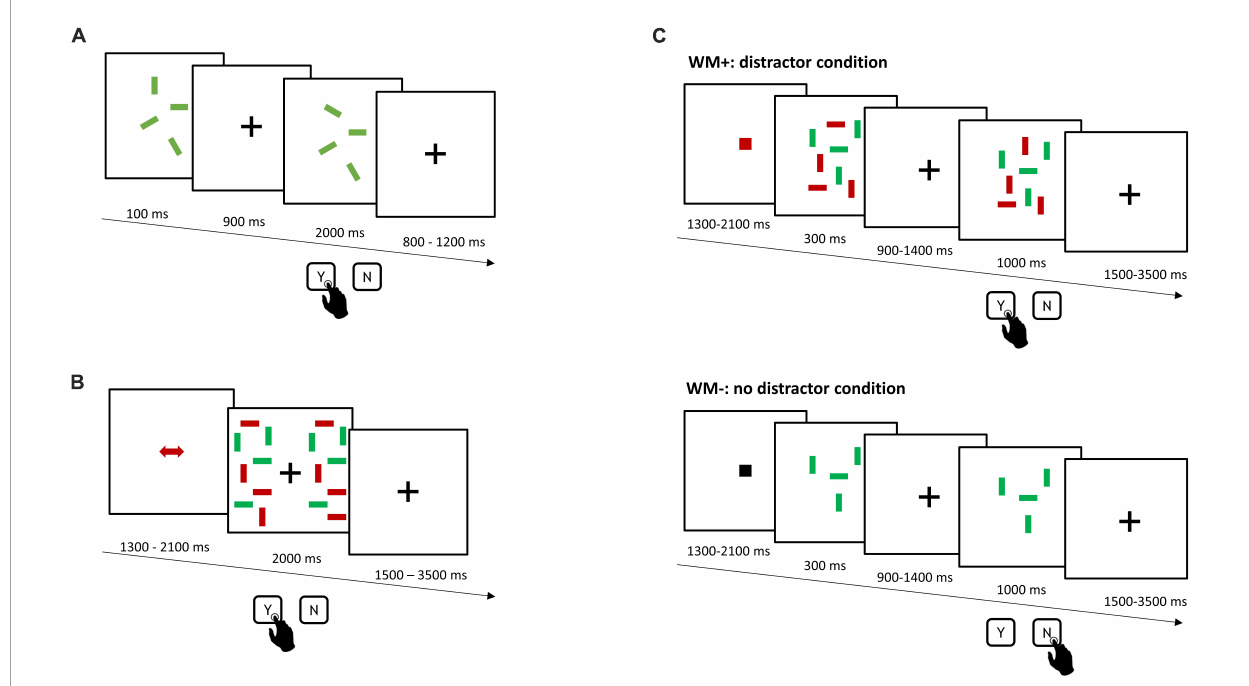
FIGURE1 Schematic overview of the experimental tasks. (A) Independent assessment of WM capacity ( WMC task ). After a short encoding phase and delay, participants had to indicate, whether orientation of rectangles had changed. (B) Single-session training of distractor inhibition ( DIIN training) . Participants compared and reported orientation differences of color-cued target rectangles across the two test display halves. (C) Working memory transfer task ( WM – /WM +). Participants encoded and remembered the orientation of color-cued target rectangles in the presence (top: distractor condition, WM+) or the absence of distractors (bottom: no distractor condition, WM–) and had to indicate, whether orientation of targets had changed. Stimulus size across all tasks was 1.43 ◦ × 0.29 ◦ viewing